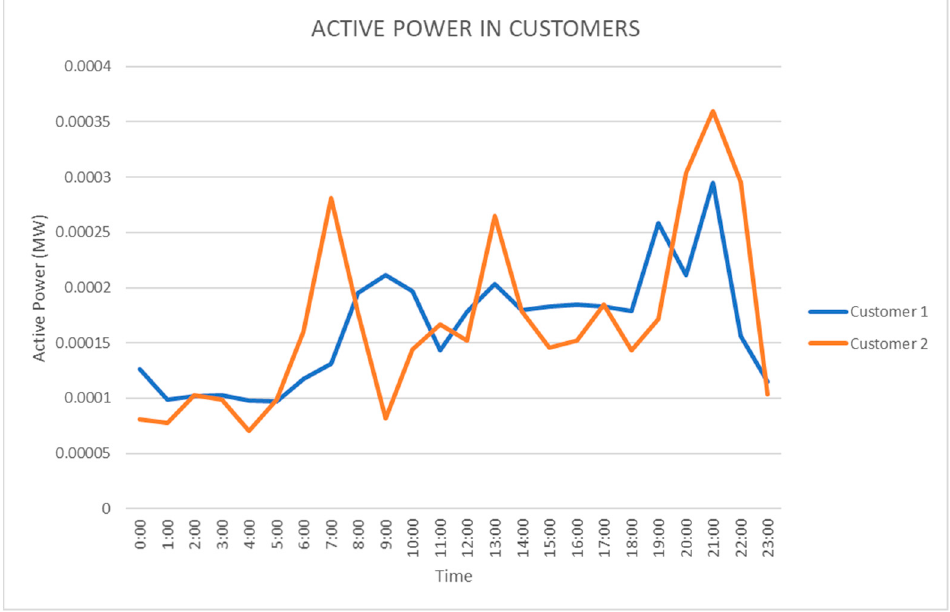
Figure A2. Active power profiles of different customers.